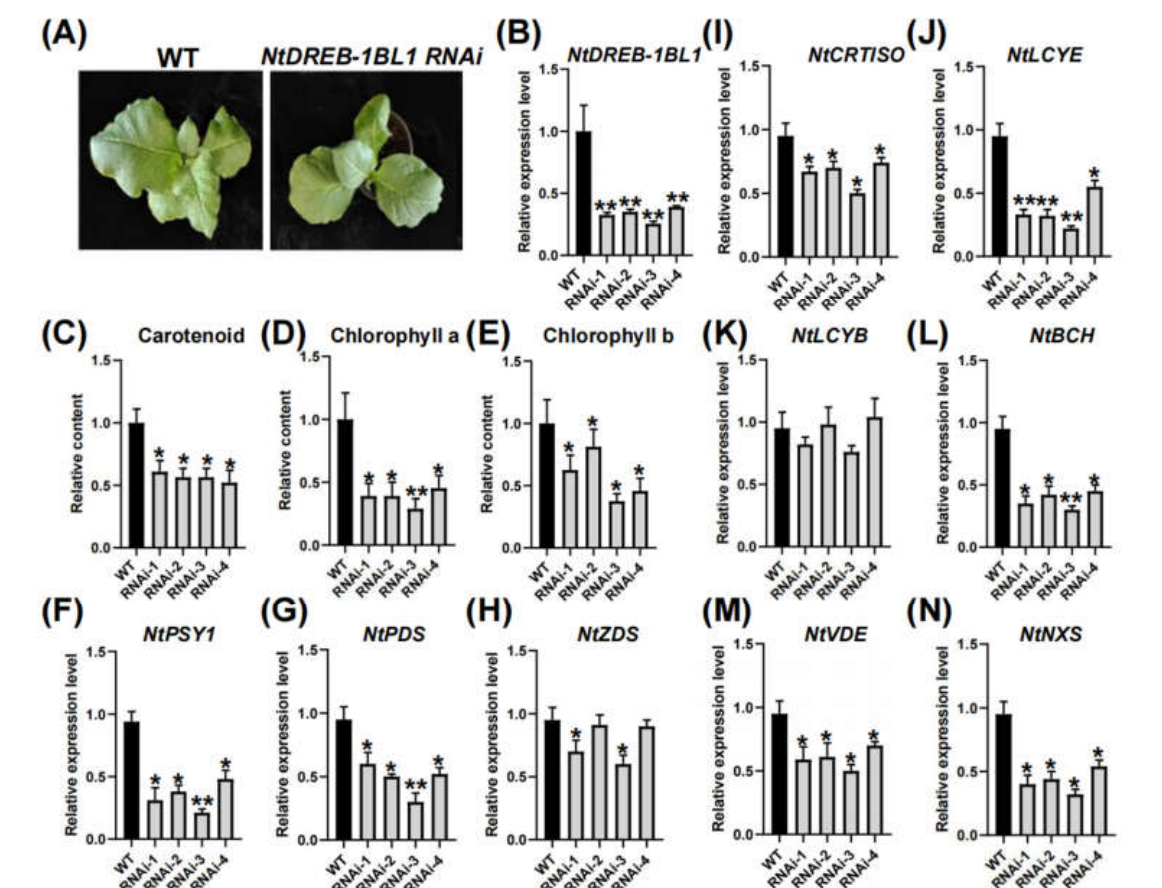
Figure 4. Inhibition of NtDREB-1BL1 decreased carotenoid contents and expression of genes related to carotenoid biosynthesis. ( A ) Phenotype of NtDREB-1BL1 RNA i transgenic tobacco. ( B ) Relative expression of NtDREB-1BL1 transcript in RNAi transgenic tobacco. ( C – E ) Relative contents of carotenoid, chlorophyll a, and chlorophyll b. ( F – N ) Relative expression of genes